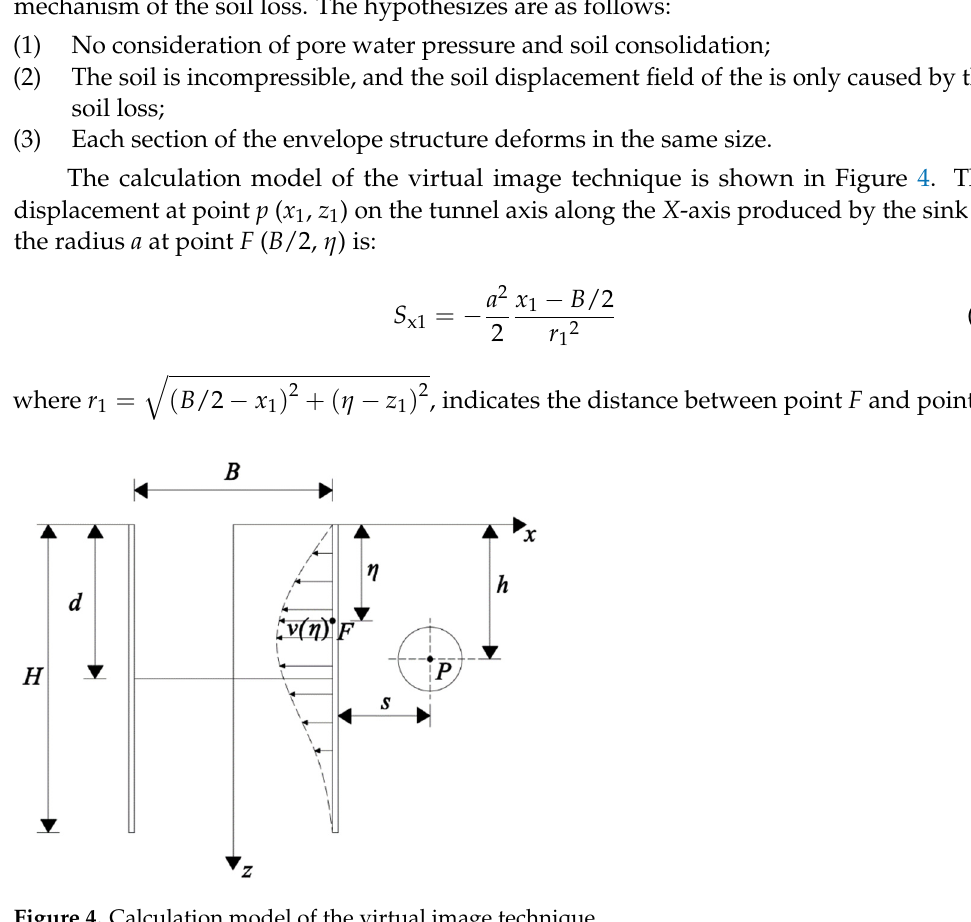
Figure 4. Calculation model of the virtual image technique.